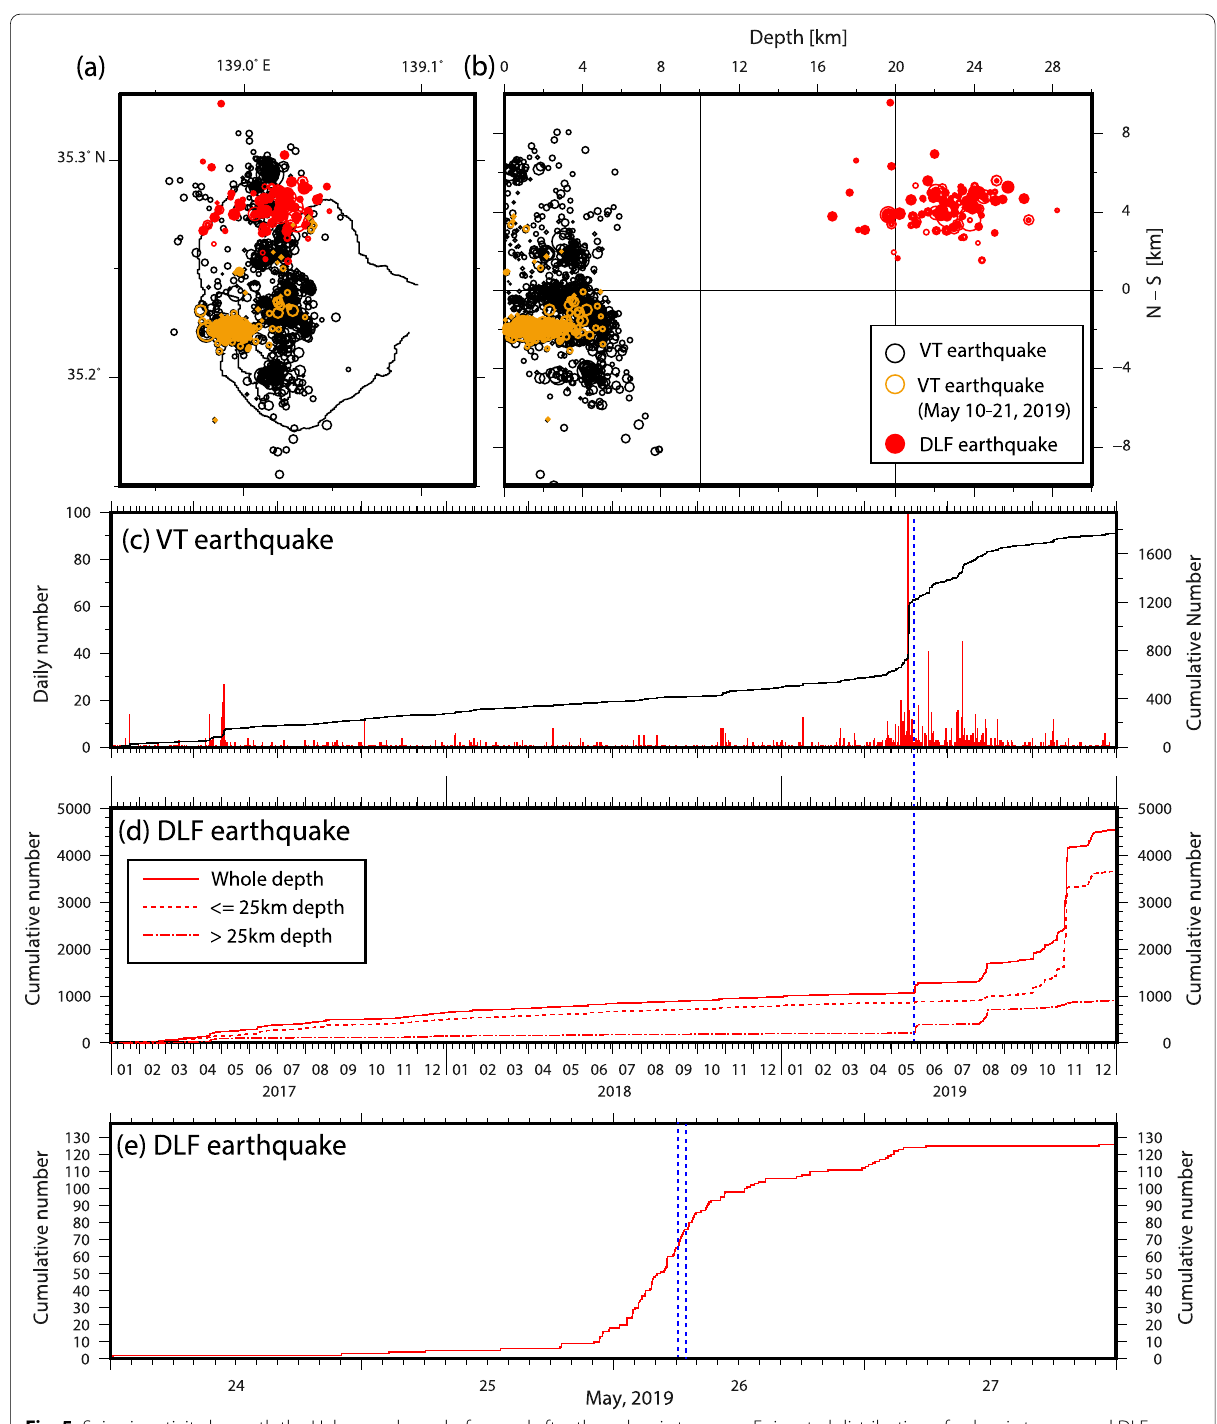
Fig. 5 Seismic activity beneath the Hakone volcano before and after the volcanic tremor. a Epicentral distribution of volcanic tremor and DLF earthquakes and b their depth distribution along with the N–S section. The black (or orange) open and red solid circles show the hypocenters of VT and DLF earthquakes, respectively. The orange circles denote the hypocenters of the earthquake swarm that occurred in May 2019. c The cumulative and the daily number of VT earthquakes, and d the cumulative number of DLF earthquakes. The two broken lines in d show the cumulative curves of DLF earthquakes at shallower and deeper depths than 25 km. e A magnified plot of the cumulative curve of DLF earthquakes during May 24–27, 2019. The vertical blue broken lines indicate the occurrence times of the volcanic tremors. The DLF earthquakes were detected by a matched filter method, whereas the VT earthquakes are based on the hypocenter catalog obtained by HSRI routine